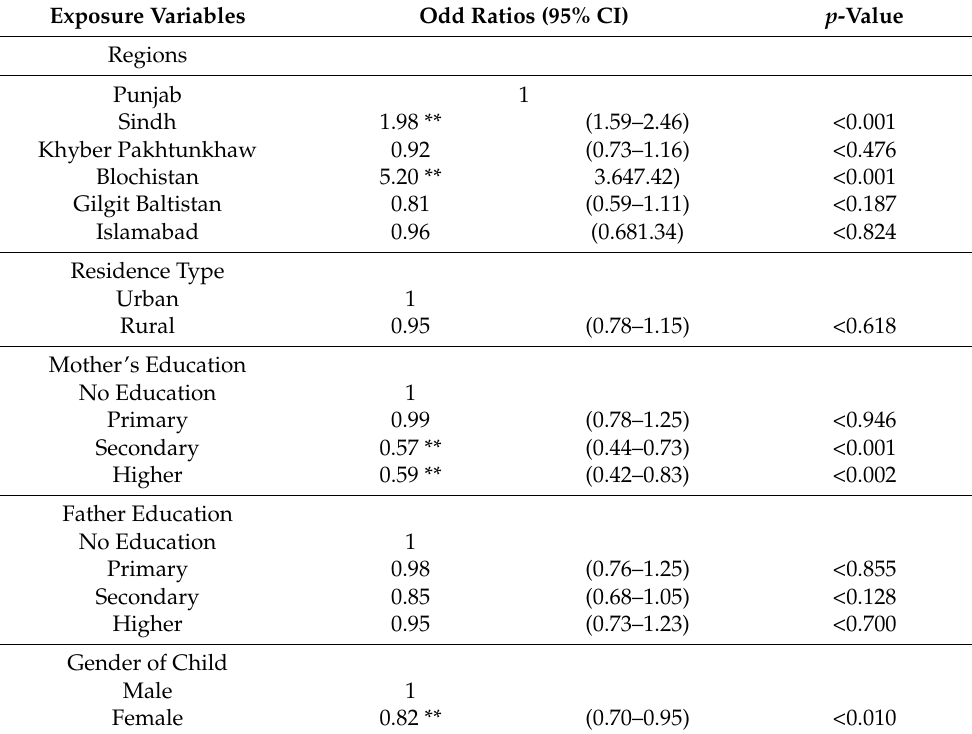
Table 3. Logistic regression analysis of factors associated with child malnutrition